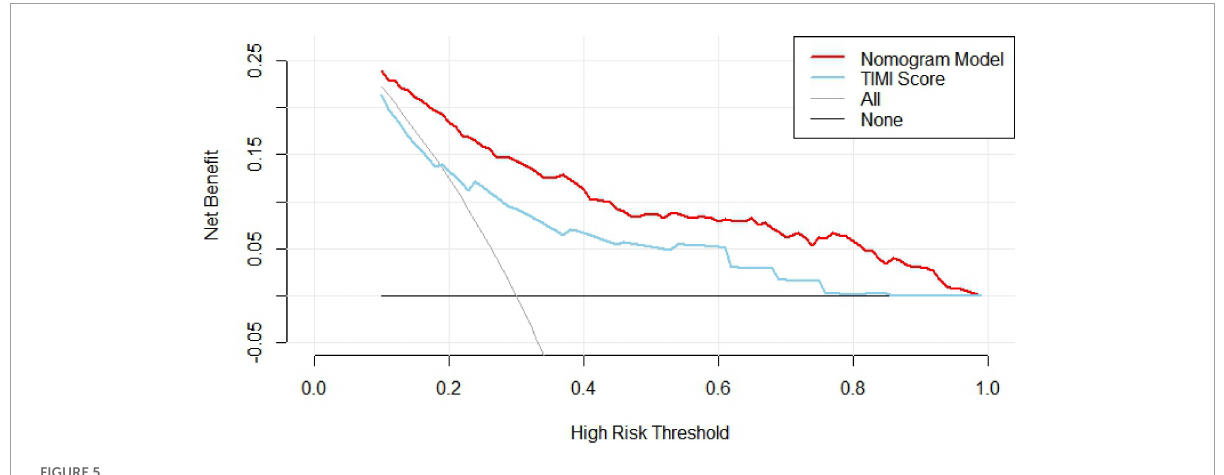
FIGURE5 Clinical decision curve analysis for nomogram models.